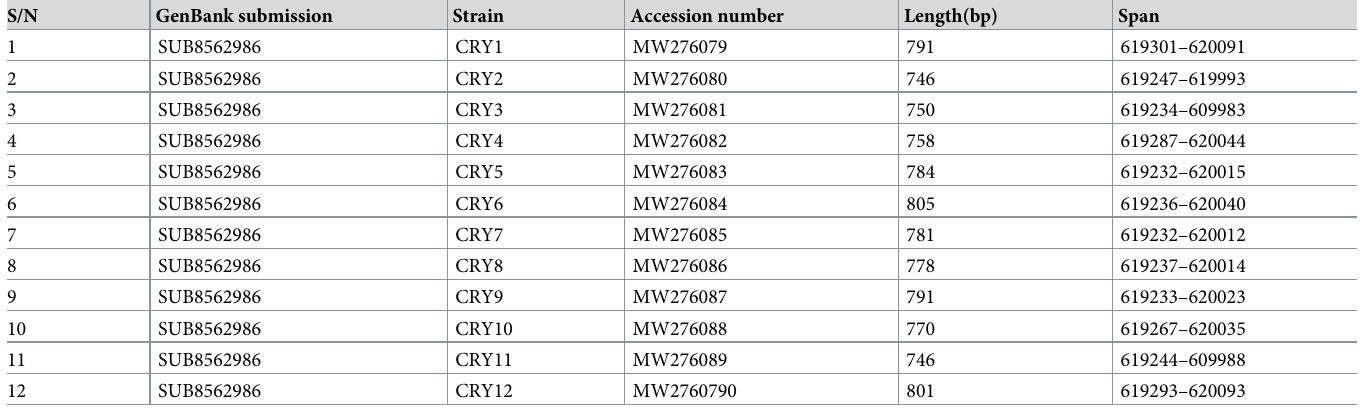
Table 2. GenBank accession numbers for the 16S rRNA gene partial sequence of Corynebacterium pseudotuberculosis isolated from dromedary camels in UAE (2015–2020) along with the length of each isolate sequence and the span on the reference genome Corynebacterium pseudotuberculosis (Accession